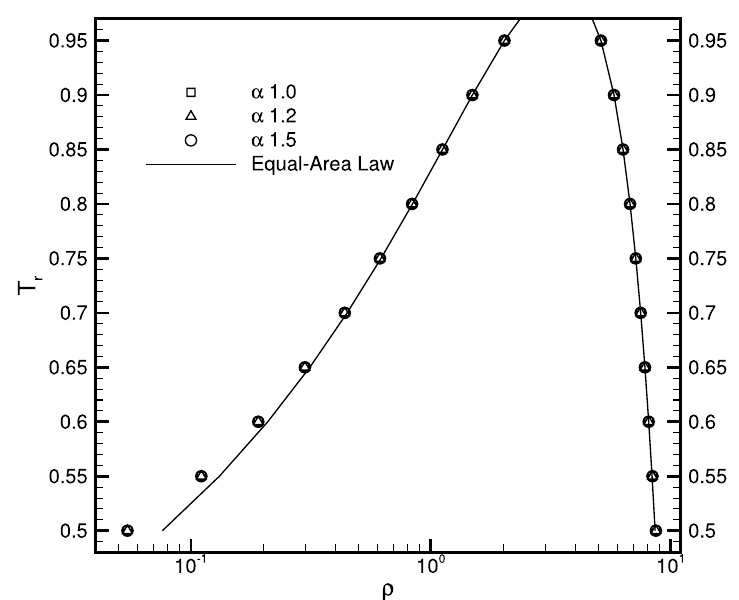
Fig. 2 Coexisting curves produced by DUGKS with varying values of isotropy-preserving parameter α , τ =